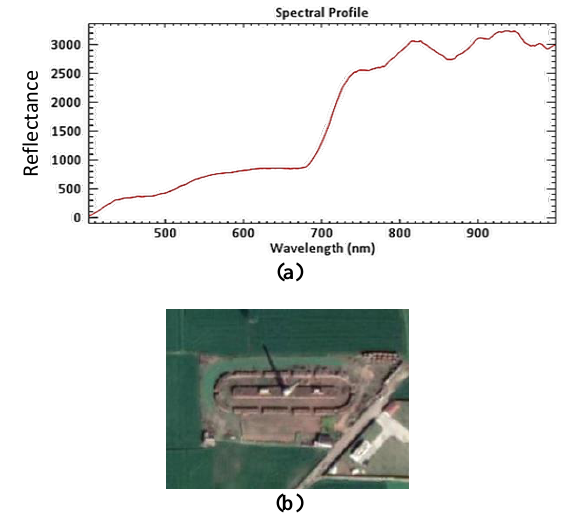
Figure 5 : (a) Spectral signature of the target mixed with vegetation, (b) HR image of the